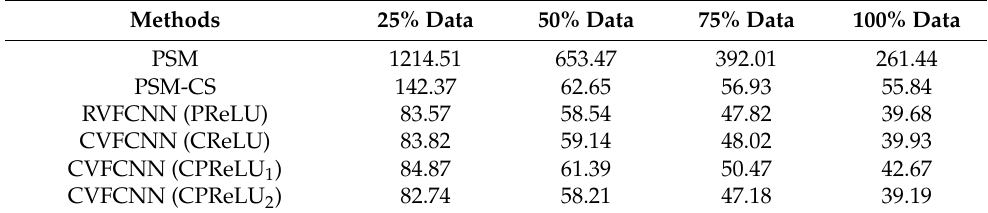
Table 2. Average SSE between imaging results and ground-truth images on the testing dataset.